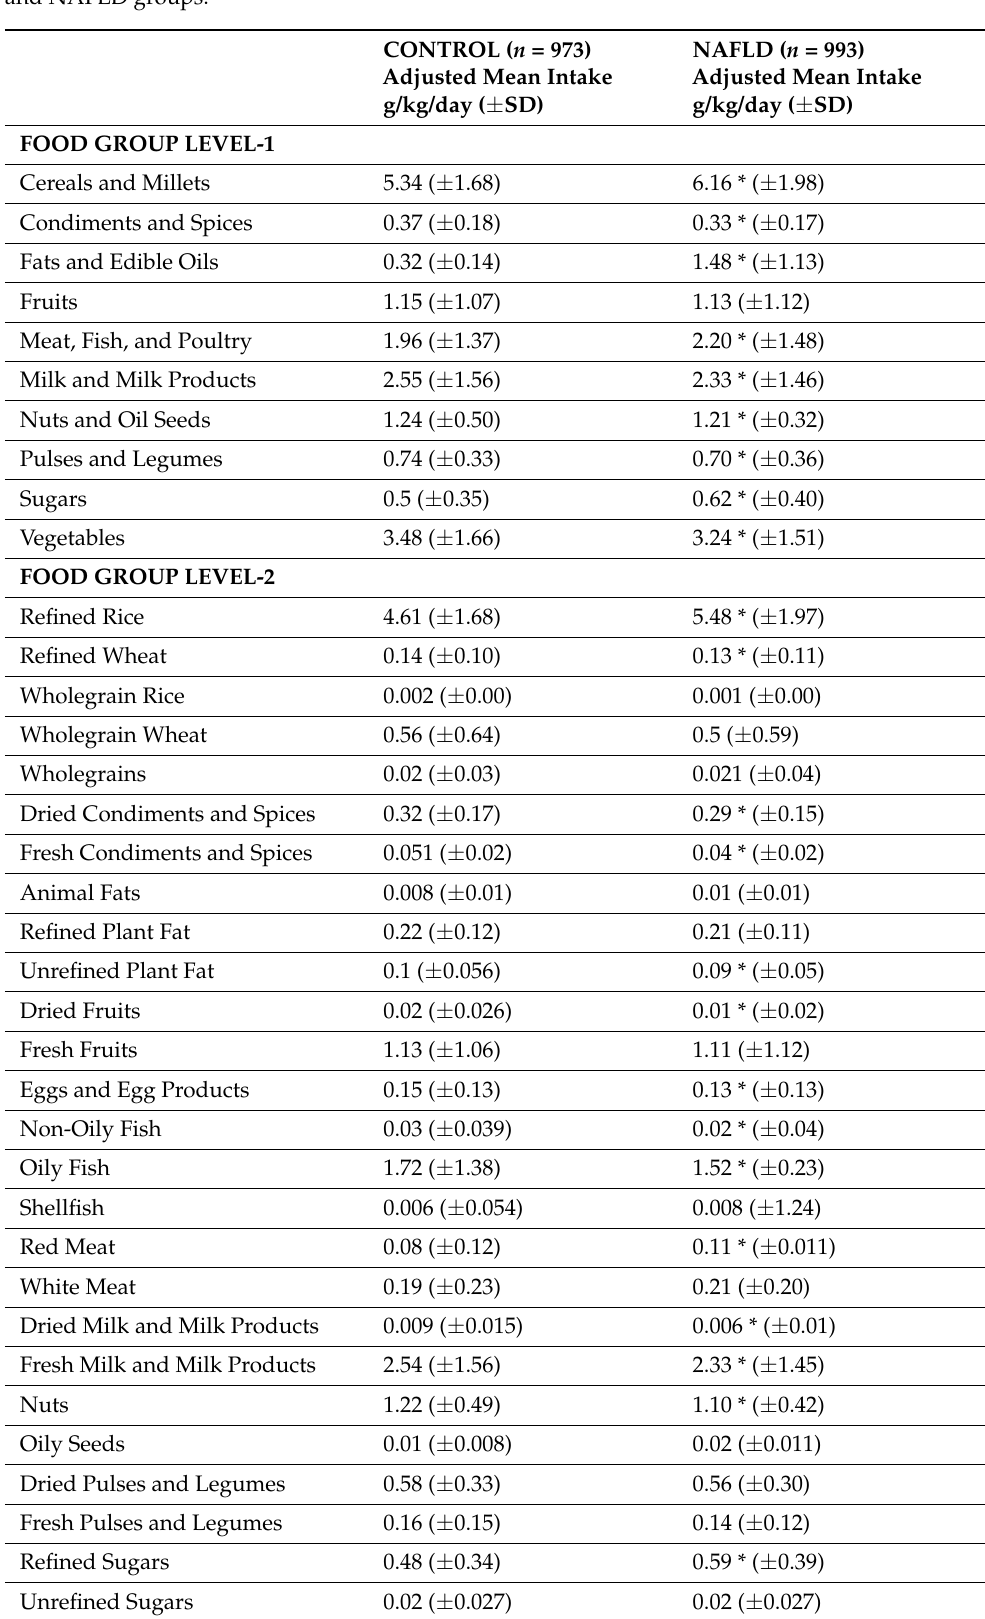
Table 2. Comparison of mean intakes of individual food groups and their associations with control and NAFLD